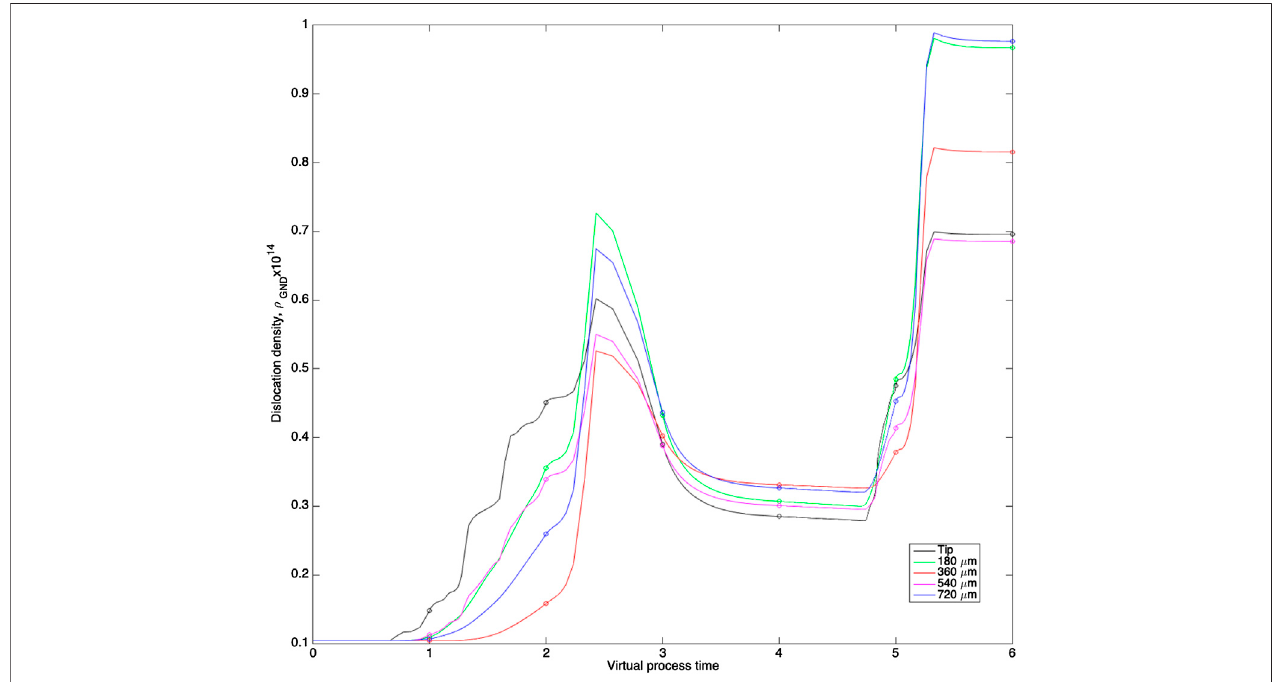
FIGURE7| Thedislocationdensityevolutionat fi ve(5)differentlocationsalongtheblacklineshownin Figure6A duringtheassemblyprocess.Thecirclesindicate the different steps in the assembly process. The values at virtual process time 6, end state, are also shown as simulated data in Figure 6B .